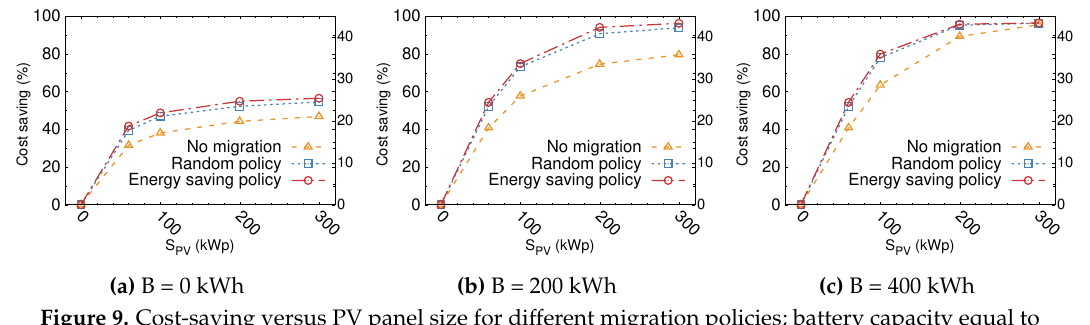
Figure 9. Cost-saving versus PV panel size for different migration policies; battery capacity equal to 0 kWh, 200 kWh and 400